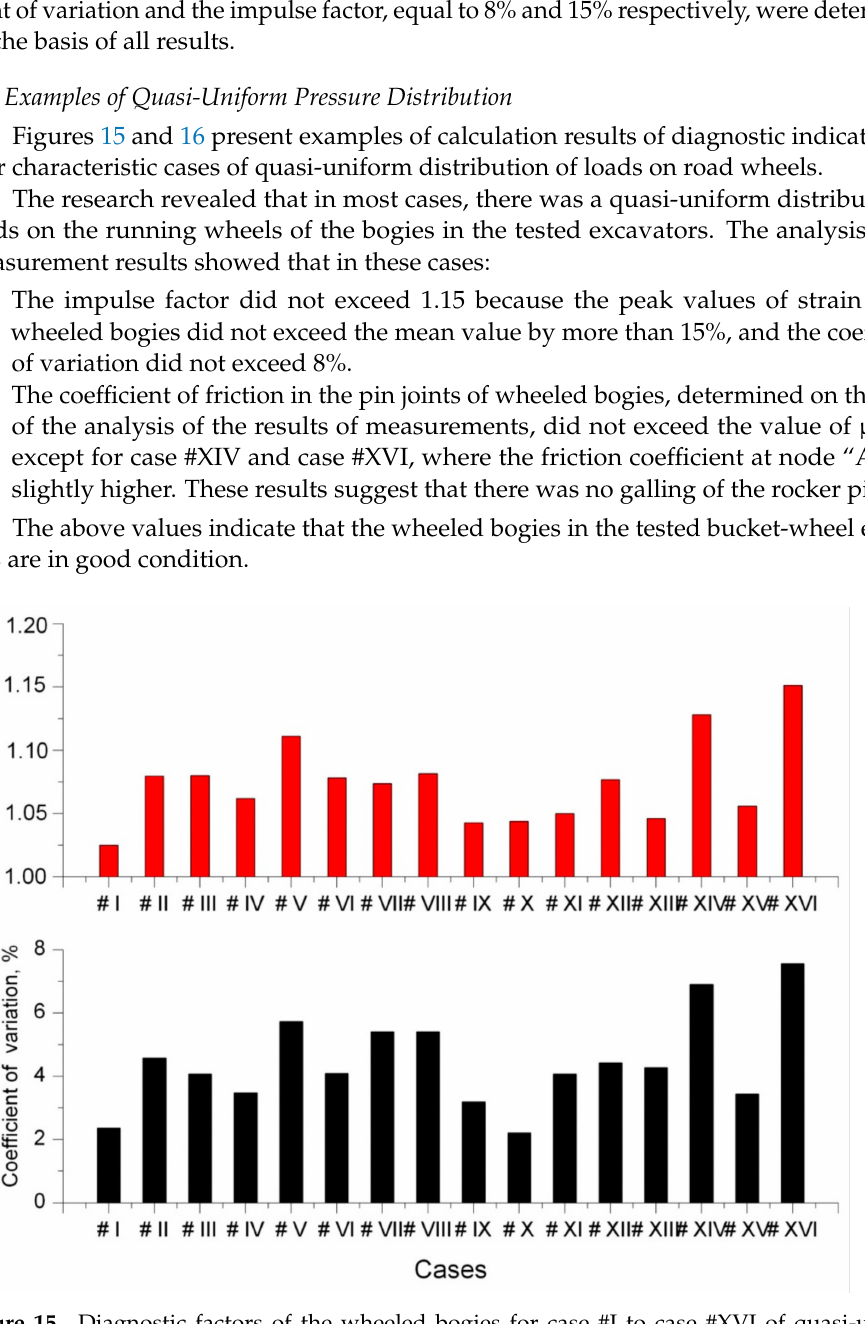
Figure 15. Diagnostic factors of the wheeled bogies for case #I to case #XVI of quasi-uniform strain